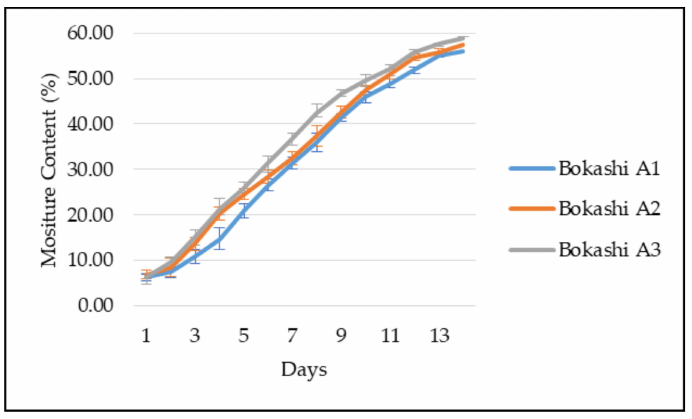
Figure 7. The observation of the moisture content of different types of bokashi from day 1 to 14.